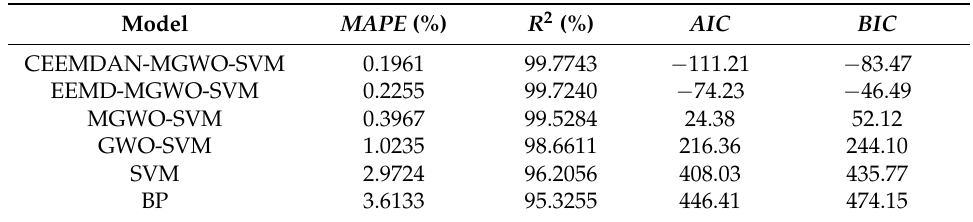
Table 5. Comparison of the forecasting accuracy for different